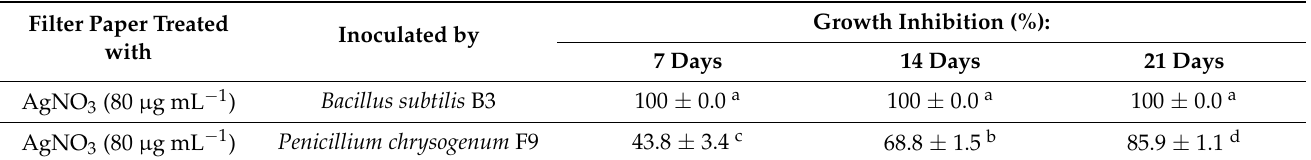
Table 1. The inhibitory effect of AgNO 3 toward Bacillus subtilis B3 and Penicillium chrysogenum F9 inoculated onto filter paper treated with 80 µ g mL − 1 AgNO 3. Filter Paper Treated Inoculated with